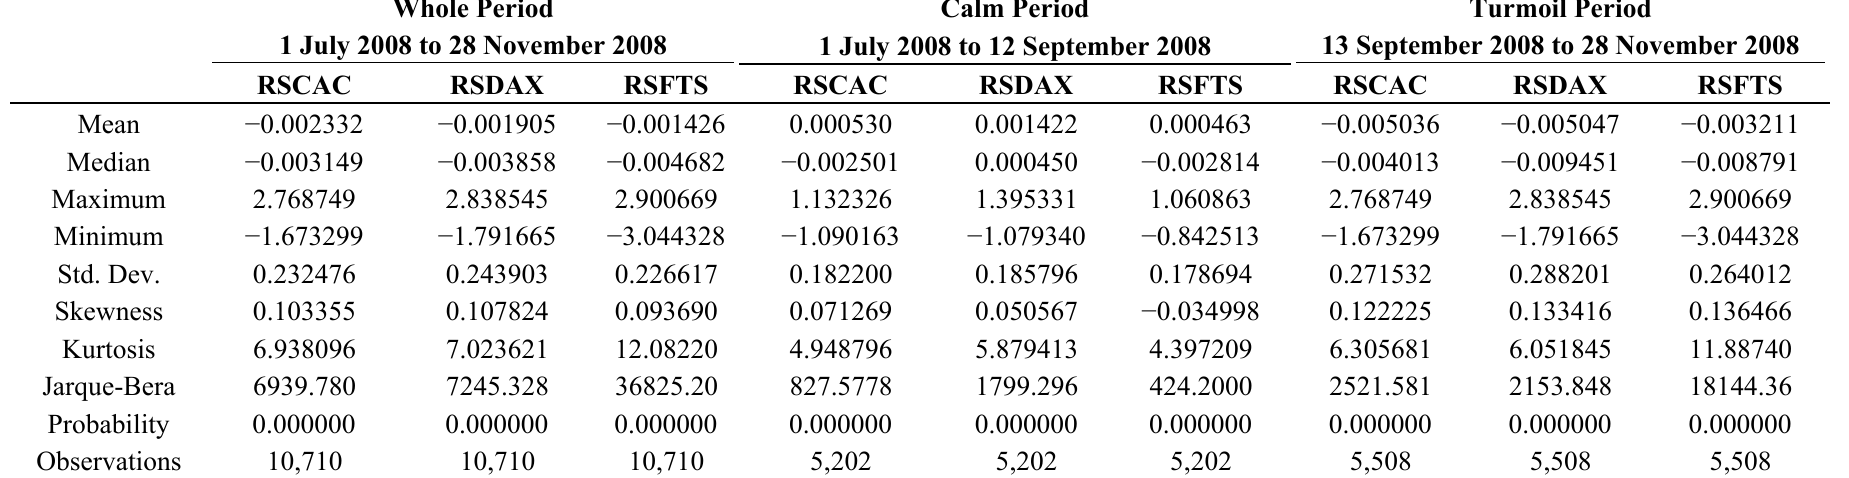
Table 1. Descriptive statistics of